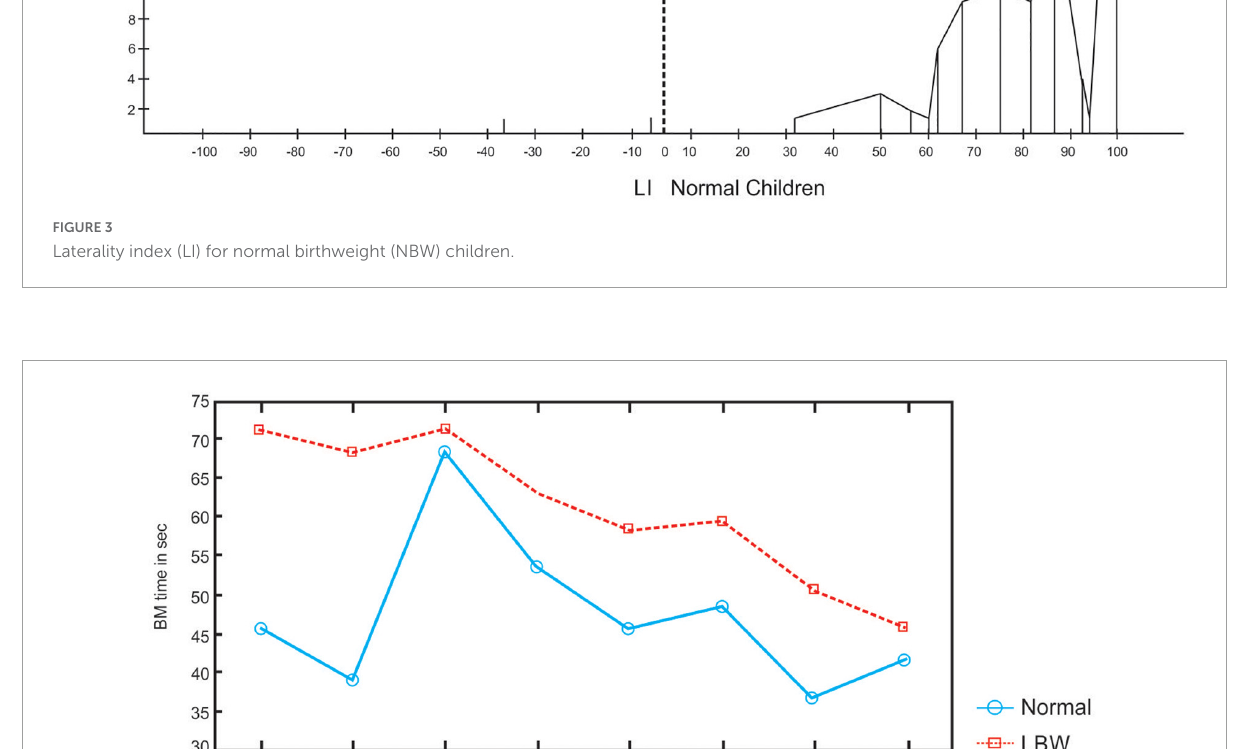
FIGURE4 Bimanual coordination times in LBW and normal birthweight (NBW)